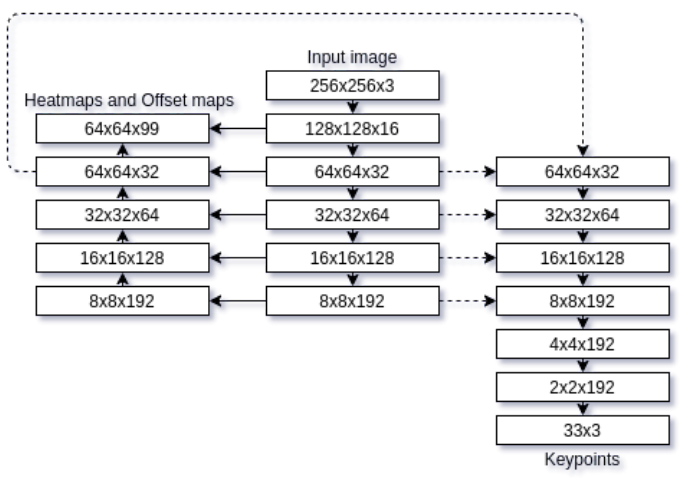
Figure 2. Backbone network